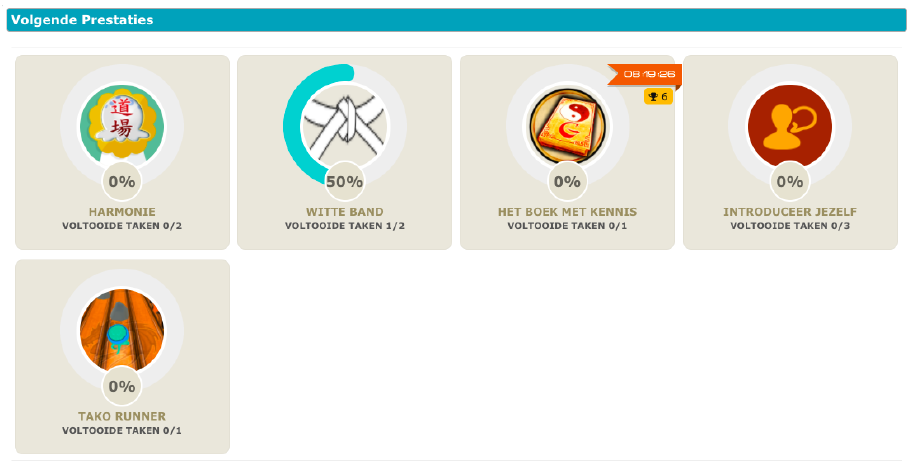
Figure 4. Gamification platform, Goals.